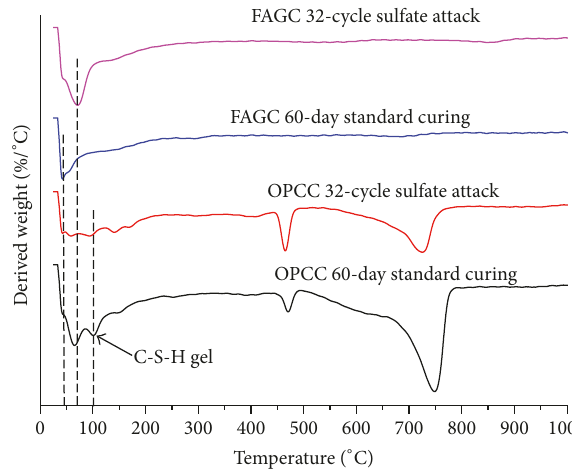
Figure 12: DTG results of OPCC and FAGC in the 60-day standard curing condition and 32-cycle MgSO4 attack